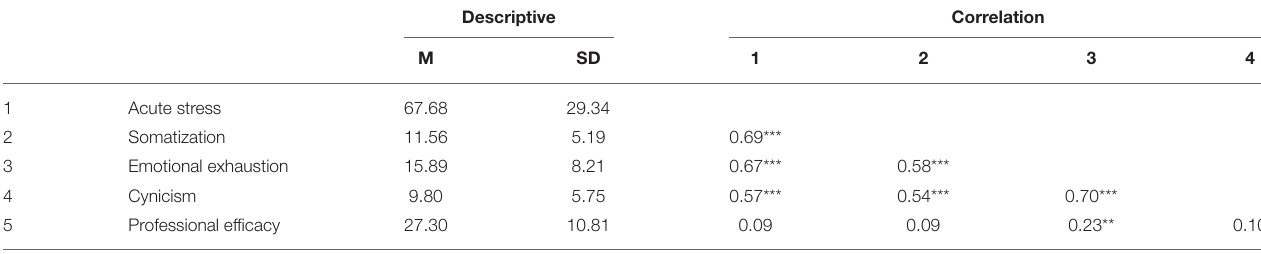
TABLE 2 | Means and SDs and bivariate correlations of the study variables.